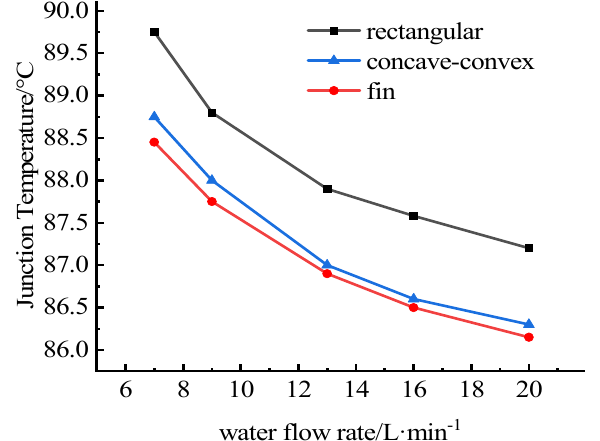
Figure 13. Relations between water flow rate and the junction temperatures of SBD chips.